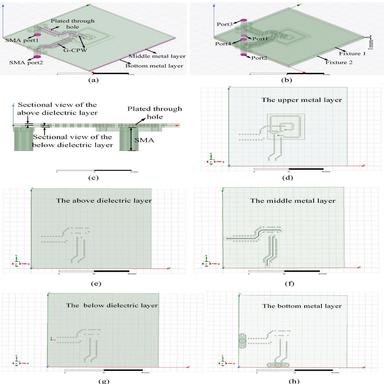
Microstrip antenna-based fixture: (a) 3D side view of a single fixture; (b) fixtures operating in pairs for testing. Layered s for a single fixre:for a single fixture: (c) 3D Profile; (d) the upper metal layer; (e) the above dielectric layer; (f) the middle metal layer; (g) the below dielectric layer; (h) the bottom metal layer.